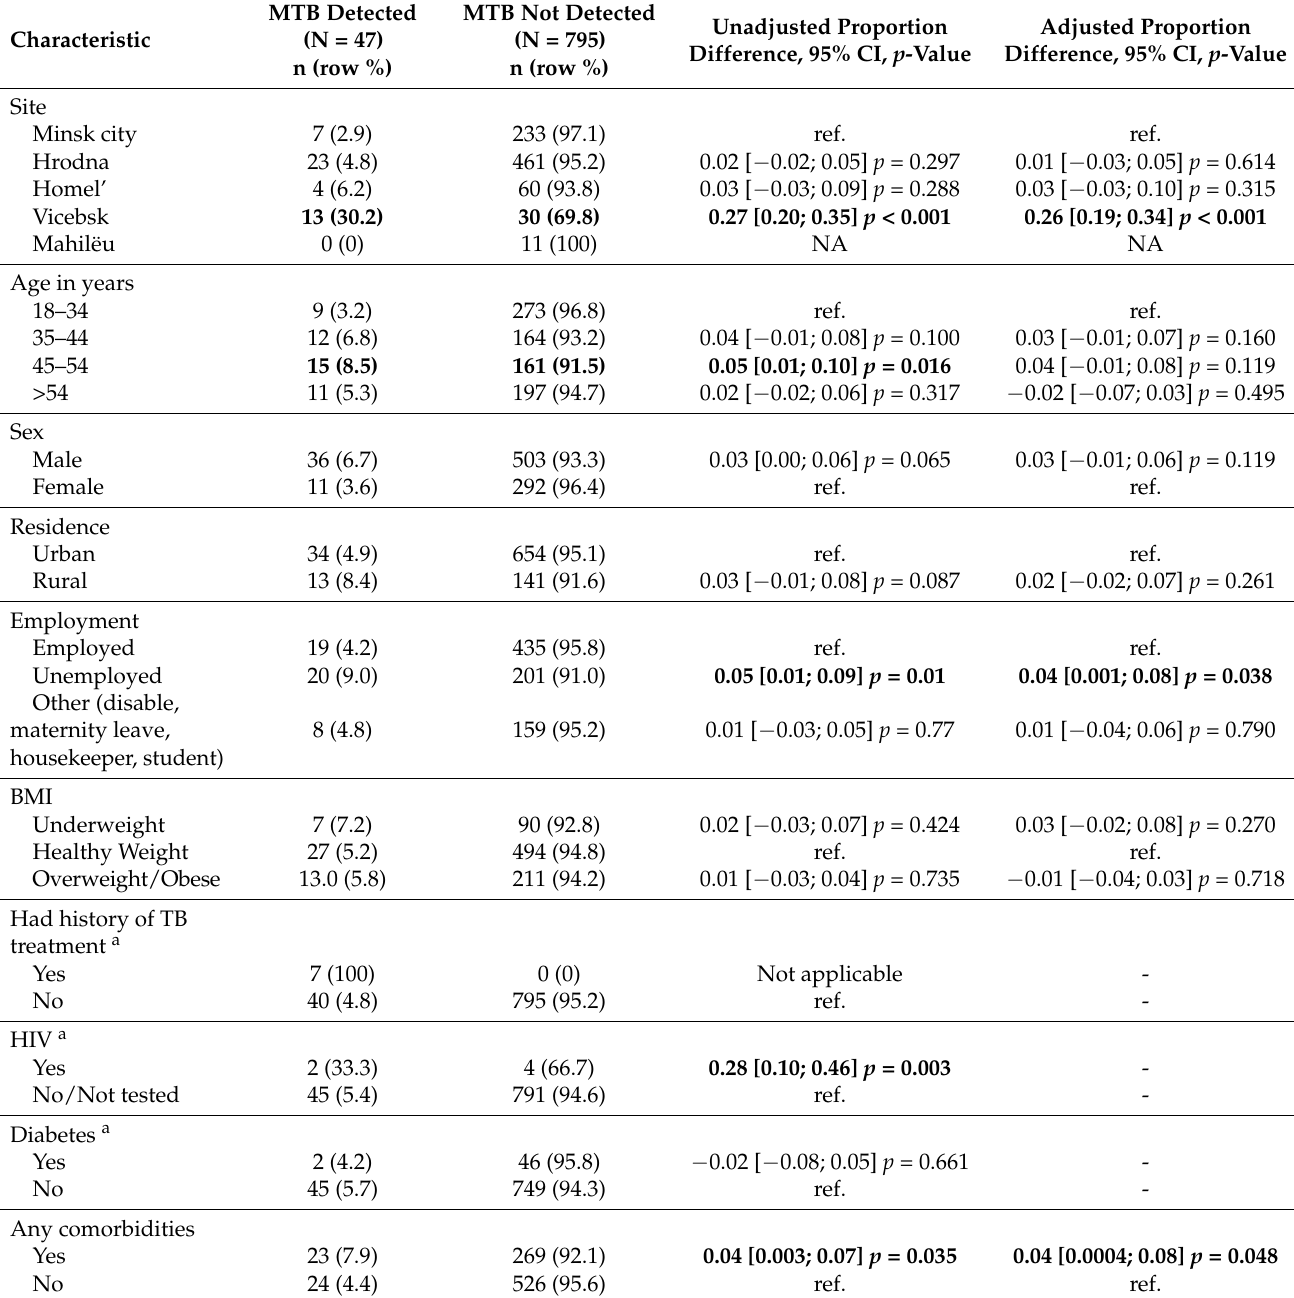
Table 4. Factors associated with laboratory-confirmed COVID-19 and TB co-infection among patients admitted to repurposed departments in TB hospitals, Belarus, April–November 2021 (among patients with valid test results, N =